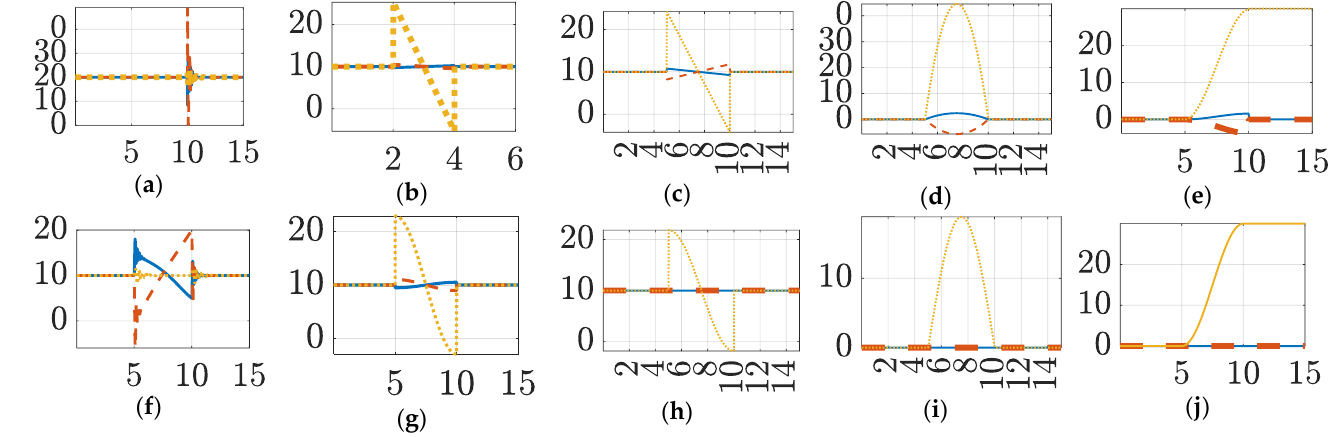
Figure 5. Comparison of system response to Pontryagin generated trajectory and Sinusoidal trajectory. Roll angle in degrees is displayed as a solid, blue line; pitch angle as a dashed red line, and yaw angle as a dotted gold line. The top row displays results using Pontryagin, while the bottom row displays results using Sinusoidal. ( a ) Feedback Control Pontryagin, ( b ) Feedforward Control Pontryagin, ( c ) Acceleration Trajectory Pontryagin, ( d ) Rate Trajectory Pontryagin, ( e ) State Trajectory Pontryagin, ( f ) Feedback Control Sinusoidal, ( g ) Feedforward Control Sinusoidal, ( h ) Acceleration Trajectory Sinusoidal, ( i ) Rate Trajectory Sinusoidal, ( j ) State Trajectory Sinusoidal.